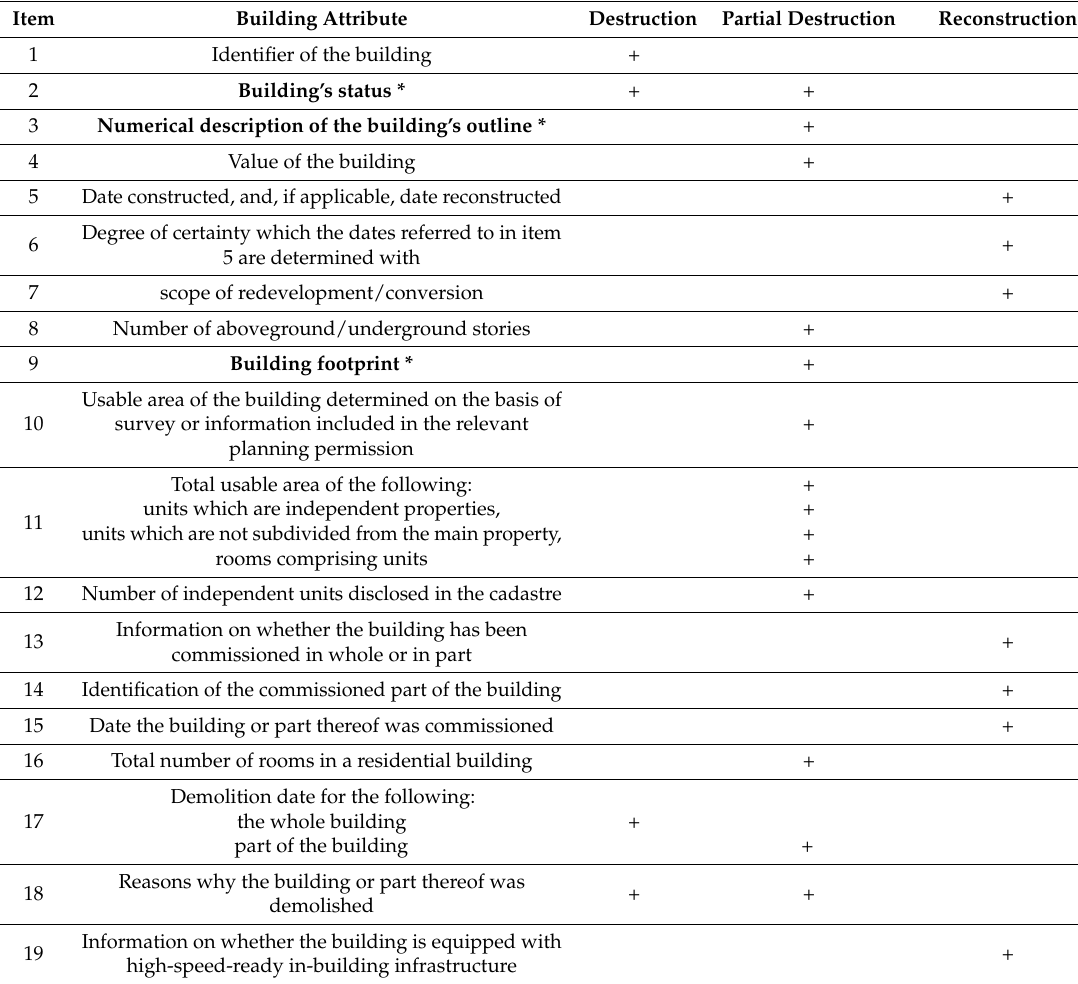
Table 2. Building attributes that may change as a result of a